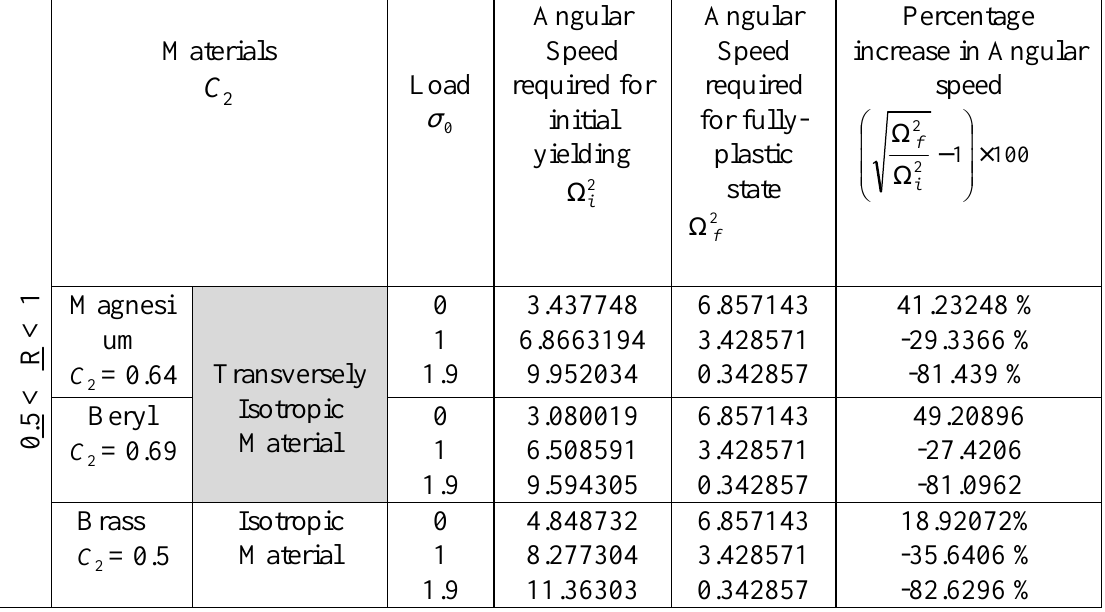
Table 2. Angular speed required for initial yielding and fully plastic